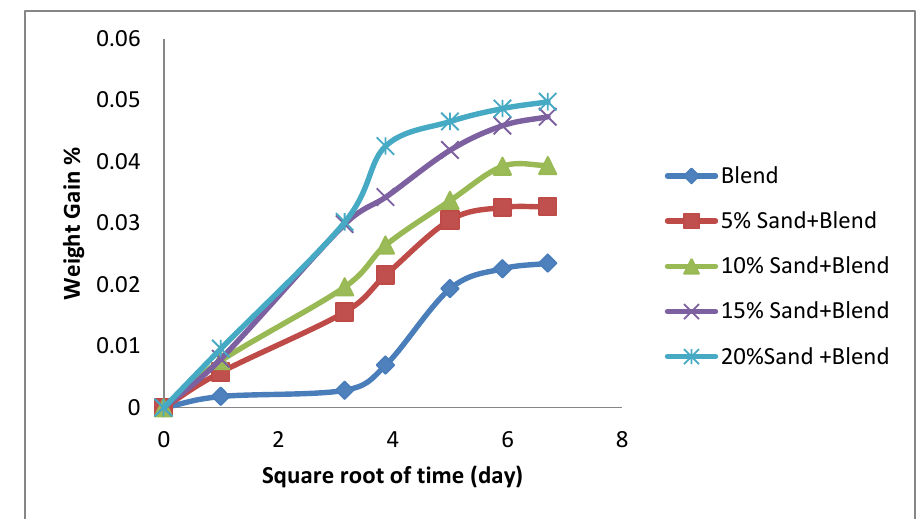
Fig. 5: The relationship between the percentages of absorption of 80%EP/20%UPE reinforced with sand Particles With square root of time after immersion in